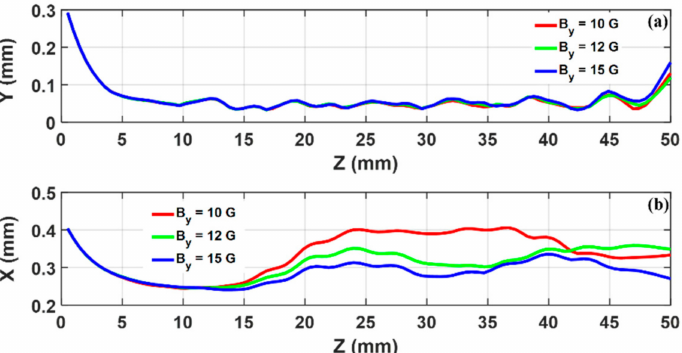
Figure 8. Simulations of the sheet beam transmission under the designed focusing magnetic fields with the side magnetic field B y ,side varied: ( a ) the trajectories envelopes in vertical direction and ( b ) the trajectories envelopes in horizontal direction.